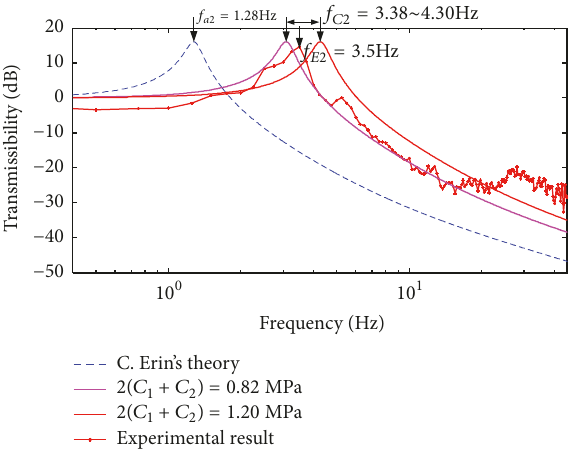
Figure 16: Transmissibility curves of experiment